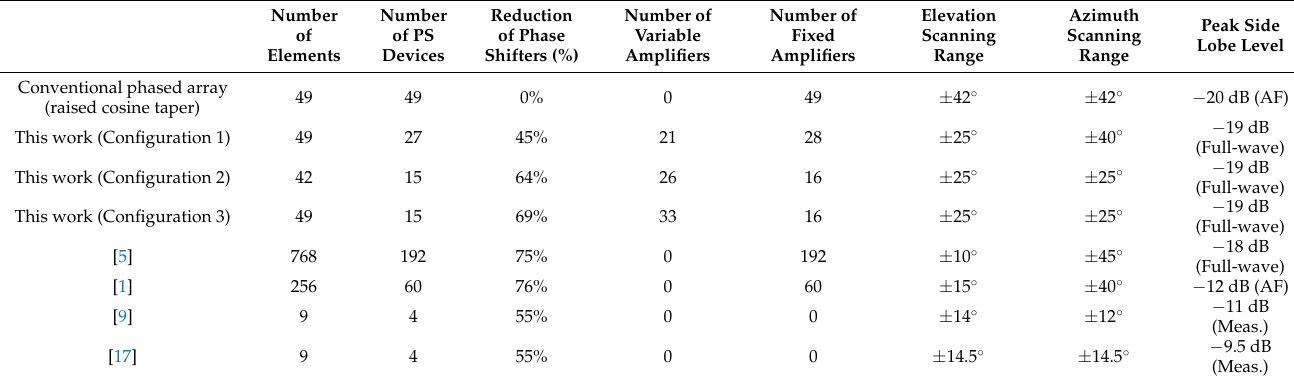
Table 5. Comparison of the three proposed configurations with respect to other existing techniques for 2-D phased